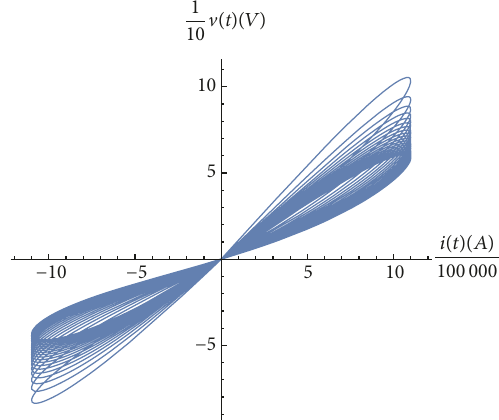
Figure 10: V (𝑡) - 𝑖(𝑡) of the fractional order memristor: 𝛼 = 1.25 and 𝐼 > 0. 𝑚